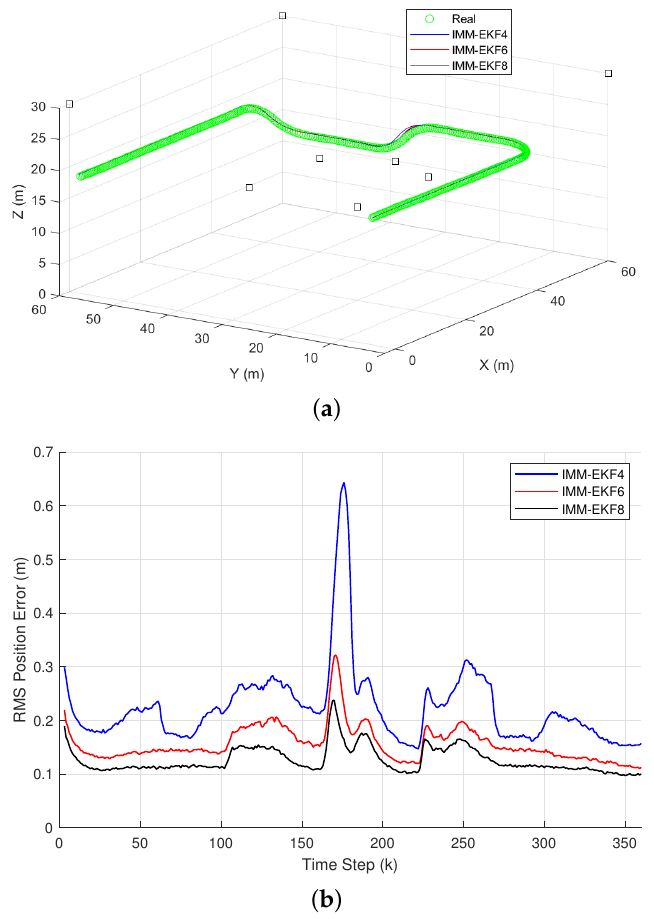
Figure 5. Results of 3D localization using IMM-EKFs with different number of NN measurements under LOS condition: ( a ) trajectory of mobile node and ( b ) RMS position